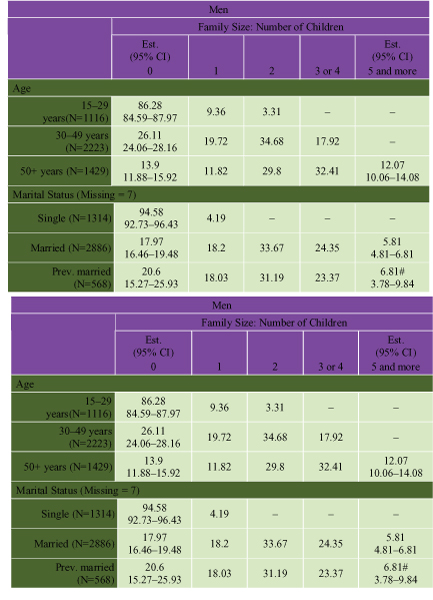
Showing the Sex Specific Distribution of Family Size by Age and Marital Status Data Source: GSS Cycle 10, 1995